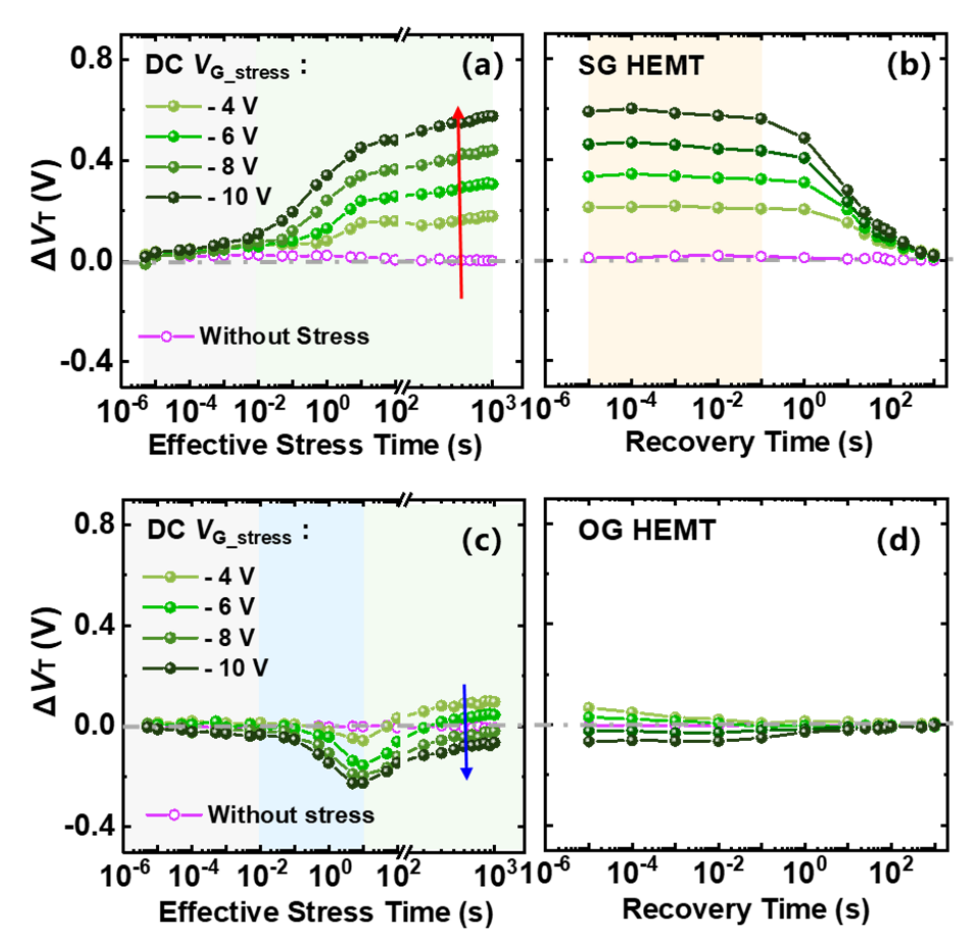
Figure 5. Transient ∆ V T evolution in 1000 s stress and subsequent 1000 s recovery processes, with gate stress from − 4 V to − 10 V, under room temperature: ( a , b ) SG HEMT, ( c , d ) OG HEMT. However, the ∆ V T evolution, with stress and recovery time, at elevated temperatures is found to be very different from the behavior at room temperature, for both SG and OG HEMTs, when conducting negative bias stress MSM sequences. As shown in Figure 6, ∆ V T , with stress time in SG HEMTs, features a concave-shaped evolution process under the given negative bias stress, and the concave shape occurs earlier and features a larger amplitude with the increasing temperature. It is very interesting that a convex-shaped V T evolution appears, correspondingly, in the recovery process. In addition, as marked by the black arrows, the final saturated ∆ V T decreases with the increasing temperature under the given gate bias